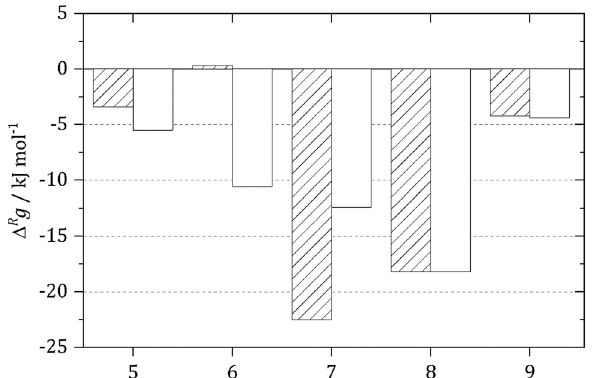
Figure 3. Comparison of the Gibbs energy of reaction (cid:31) R g determined considering substrates and products of the respective reaction for prediction of Q γ (striped bars) and (cid:31) R g determined considering all metabolites involved in glycolytic pathway (best-case concentrations for reaction participants + maximum concentration for the other metabolites within glycolysis, see Table S4) and 1 mmol kg −1 MgC l 2 and 100 mmol kg −1 KCl for prediction of Q γ (white bars) of the glycolytic TPI reaction (5), GAPDH reaction (6), PGK reaction (7), PGAM reaction (8) and enolase reaction (9) at 298.15 K and pH